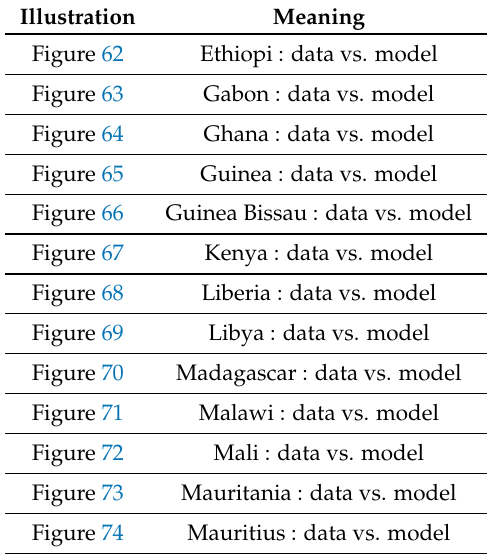
Table 7. List 4 of figures and illustrations. data of active, recovered, deceased (in circle or bar) vs. model of active, recovered, deceased over time. Tracking the number of active cases. Predictive analytics for the next couple days. Illustration Meaning Figure 62 Ethiopi : data vs. model Figure 63 Gabon : data vs. model Figure 64 Ghana : data vs. model Figure 65 Guinea : data vs. model Figure 66 Guinea Bissau : data vs. model Figure 67 Kenya : data vs. model Figure 68 Liberia : data vs. model Figure 69 Libya : data vs. model Figure 70 Madagascar : data vs. model Figure 71 Malawi : data vs. model Figure 72 Mali : data vs. model Figure 73 Mauritania : data vs. model Figure 74 Mauritius : data vs. model Figure 75 Morocco : data vs. model Figure 76 Mozambique : data vs. model Figure 77 Namibia : data vs. model Figure 78 Niger : data vs. model Figure 79 Nigeria : data vs. model Figure 80 Rwanda : data vs. model Figure 81 Senegal : data vs. model Figure 82 Seychelles : data vs. model Figure 83 Somalia : data vs. model Figure 84 South Africa : data vs. model Figure 85 Sudan : data vs. model Figure 86 Togo : data vs. model Figure 87 Tunisia : data vs. model Figure 88 Uganda : data vs. model Figure 89 Zambia : data vs. model Figure 90 Zimbabwe : data vs.